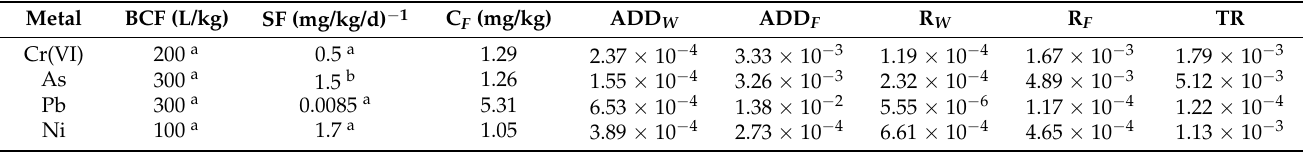
Table 6. Estimated carcinogenic risk for Cr(VI), As, Pb, and Ni from drinking water and fish consumption by the native residents of Taihu